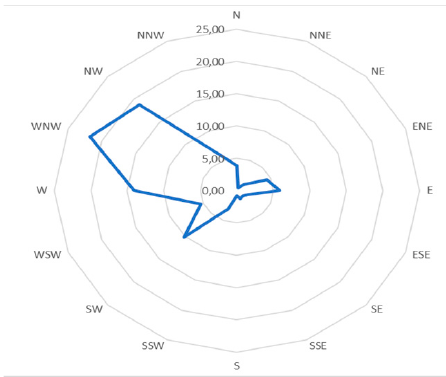
Figure 8. Wind direction probability distribution for strong winds ( ≥ 7.5 m / s). Data obtained from the Spanish Port Agency ( Puertos del Estado ) during the February 2002–January 2007 period.